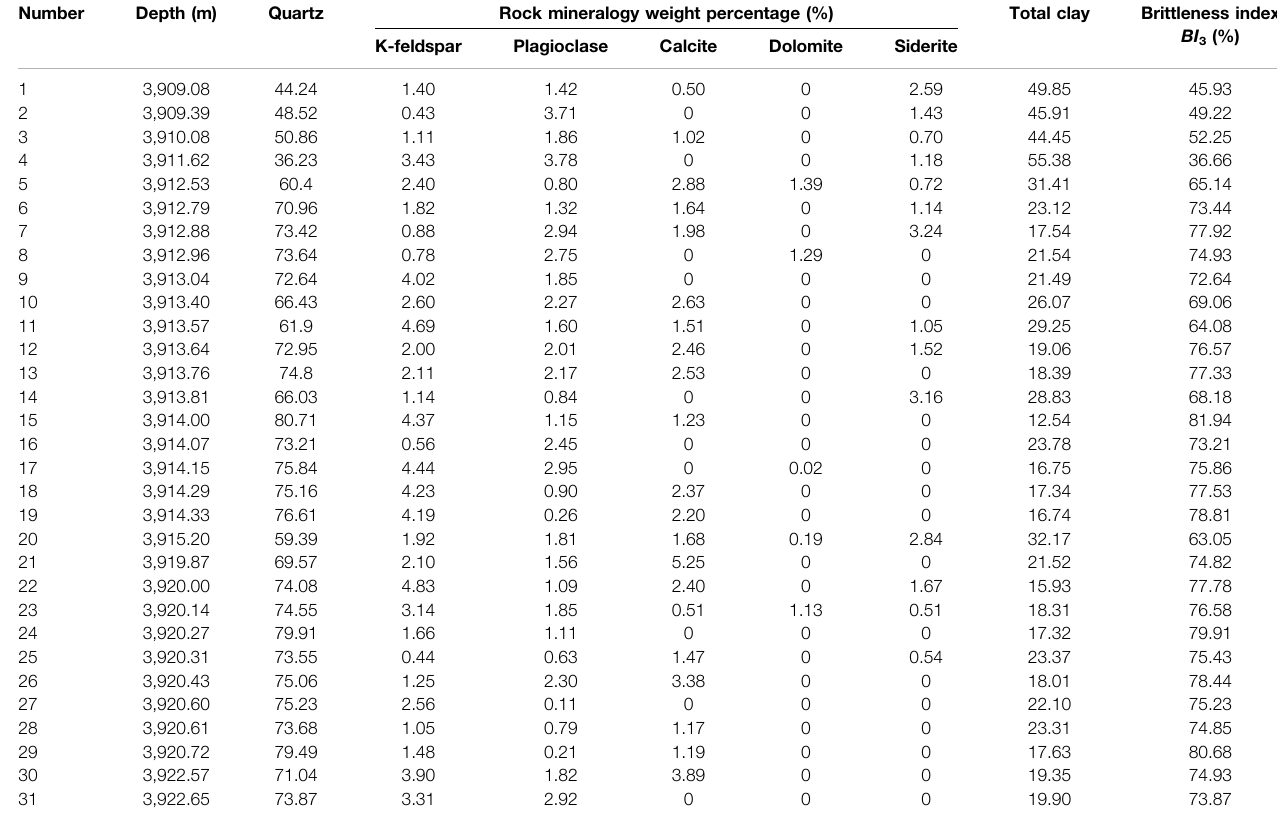
TABLE 1 | Quantitative analysis of whole rock minerals by X-ray diffraction and brittleness index. Number Depth (m) Quartz Rock mineralogy weight percentage (%)